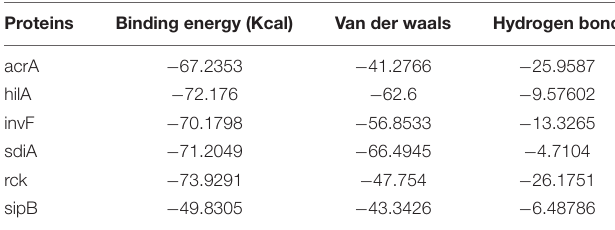
TABLE 3 | Binding affinity of pyrogallol to Salmonella Typhimurium virulence proteins. Proteins